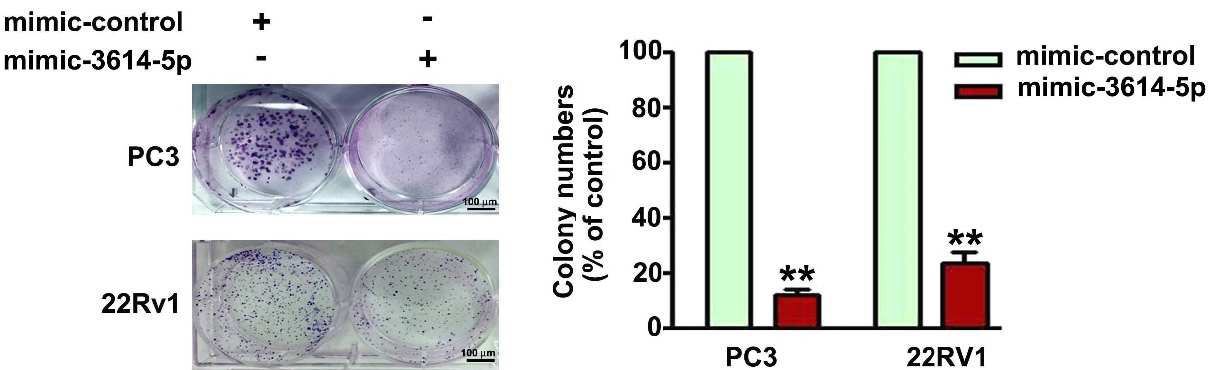
Figure 2. Effect of miRNA-3614-5p on colony formation of human PC3 and 22Rv1 prostate cancer cells. The cell growth rate of human PC3 and 22Rv1 prostate cancer cells transfected with mimic- control or mimic-3614-5p for 1 week was measured using a colony formation assay. Cells transfected with mimic-control as the control group. **, p < 0.01 versus control (mean ± SE, n = 3). Mimic-3614-5p as mimic miRNA-3614-5p. Scale bar, 100 μ m.